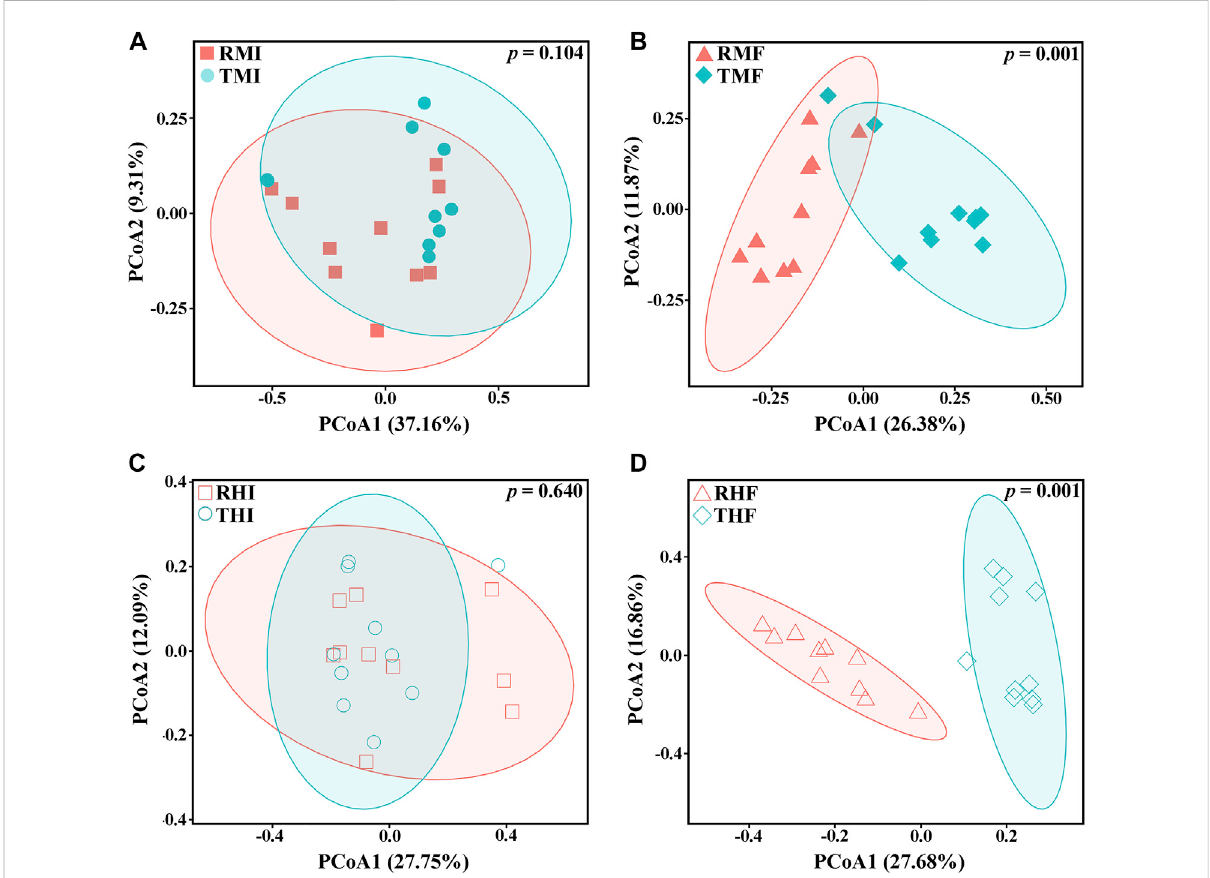
FIGURE 3 Plots of principal coordinates analysis (PCoA) of the gut microbiota of genetically improved farmed tilapia, based on unweighted UniFrac distance matrices. (A) RMI vs. TMI, (B) RMF vs. TMF, (C) RHI vs. THI, and (D) RHF vs. THF (for abbreviations, see caption to Figure 1). Each point represents a sample. Signi fi cance of the data was estimated using